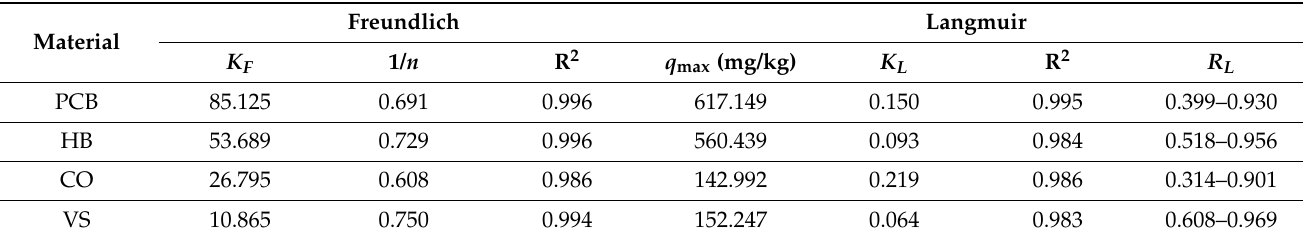
Table 3. Parameters for Freundlich and Langmuir isotherms of ammonium adsorption. Material